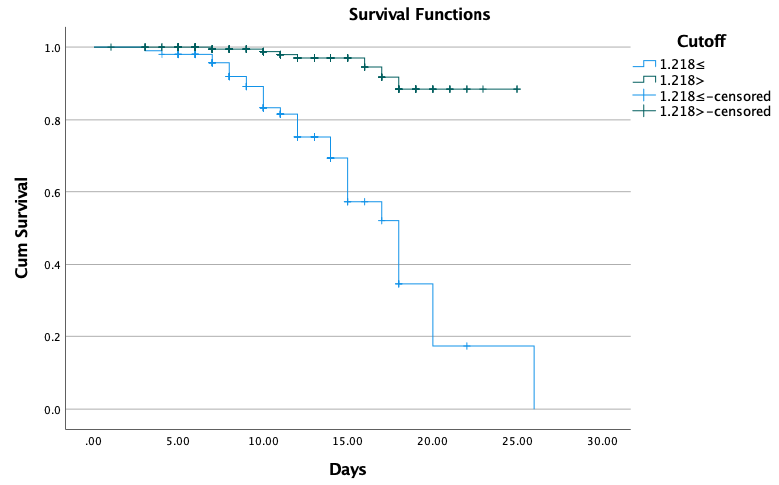
Figure 3. Kaplan–Meier survival analysis of COVID-19 patients stratified by the De Ritis ratio using